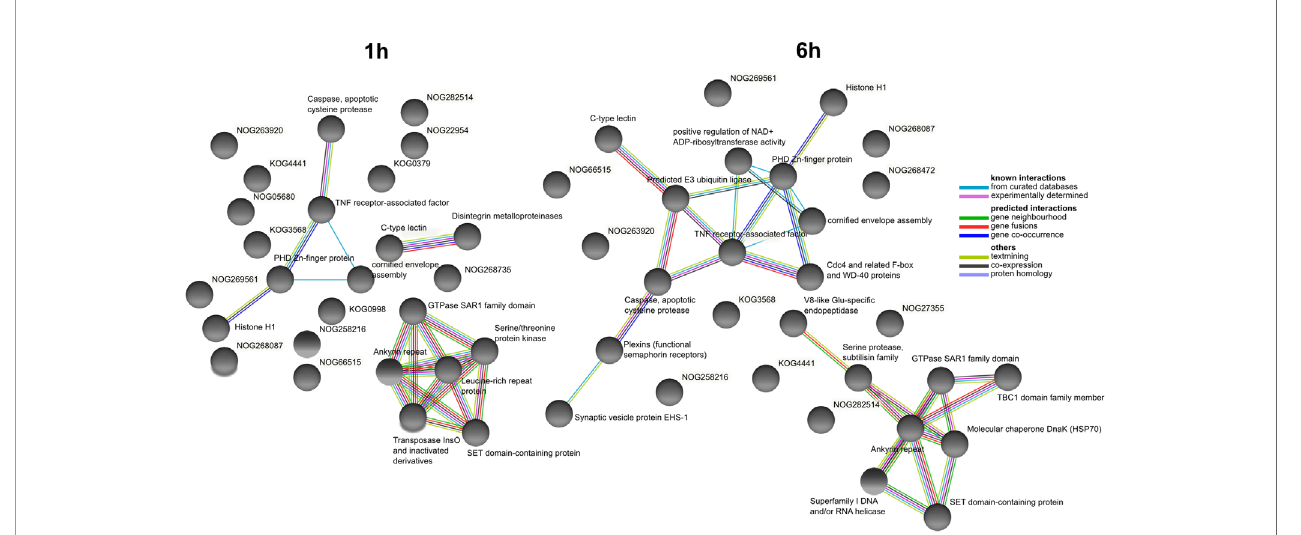
FIGURE 6 | COG association network analysis from DEGs at 1 h and 6 h after LPS exposure identi fi ed from closest annotated proteins in Amphimedon queenslandica . Created with STRING. Edges represent protein-protein associations coded by color according to the type of evidence for the shown